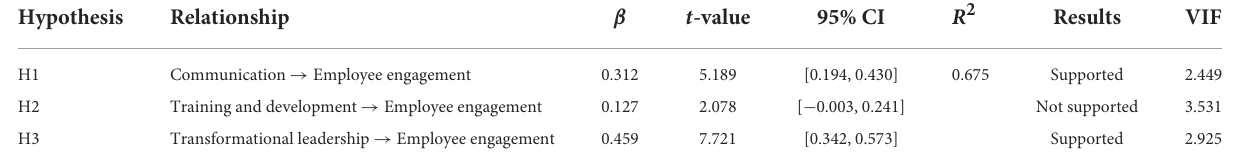
TABLE 4 Results of the hypothesis